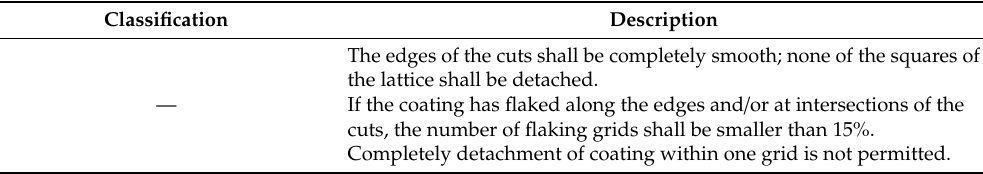
Table 3. Evaluation criterion according to GB 10810.4.